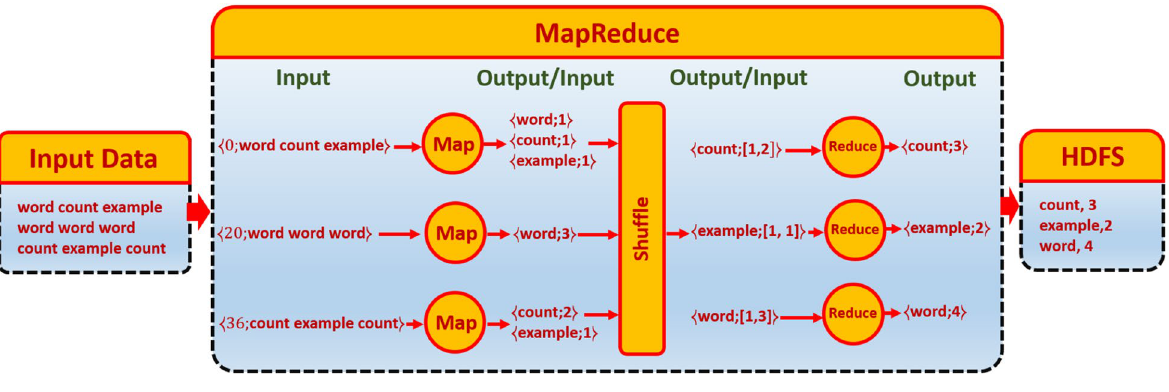
Figure 1. An illustrative example of how MapReduce